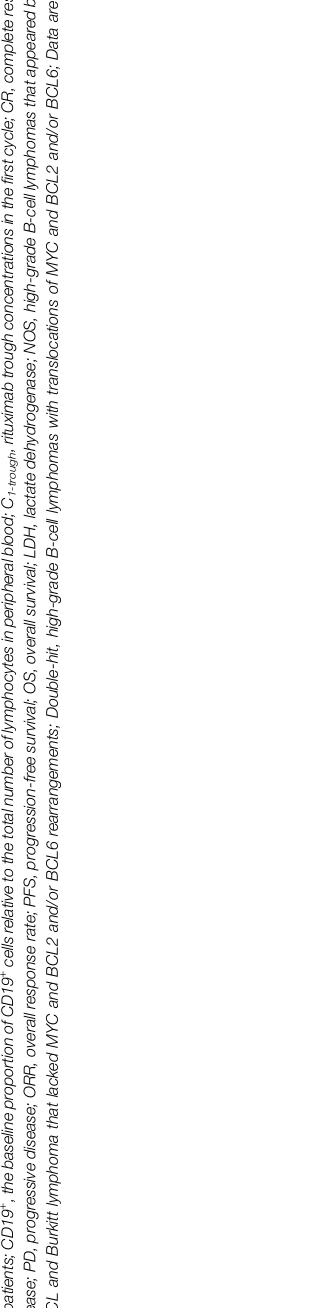
Data are presented as the median (range). Indolent lymphomas included marginal zone lymphoma and mantle cell lymphoma classical type with ki-67 ≤ 30%. Aggressive lymphomas included high-grade B-cell lymphomas, Burkitt lymphoma, unclassi fi able B-cell lymphoma (intermediate between DLBCL and classical Hodgkin ’ s), mixed B-cell lymphoma and mantle cell lymphoma with ki-67 > of 19.91 μ g/ml. The rituximab C 1-trough values of the other 3 patients were 32.87, 36.67, and 48.49 μ g/ml, respectively, and all of them achieved a CR with fi rst-line treatment and have not relapsed so far. Mixed B-Cell Lymphoma The rituximab C 1-trough for 9 patients diagnosed with DLBCL mixed with FL ranged from 20.27 to 34.47 μ g/ml, and two patients diagnosed with DLBCL mixed with MALT had a rituximab C 1-trough of 20.38 – 36.34 μ g/ml, respectively ( Table 3 ). The median C 1-trough for these patients was 25.46 μ g/ml. One patient (DLBCL mixed with FL) progressed rapidly with a C 1-trough of 22.41 μ g/ml, and OS was short as T A